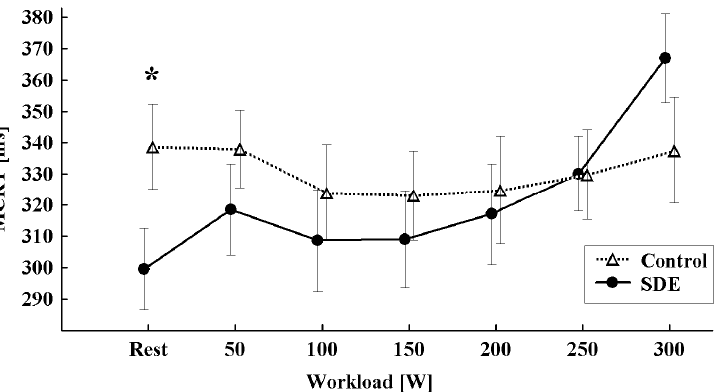
Figure 2. The multiple-choice reaction time (MCRT) during the graded exercise test to exhaustion in Control and after 30 h of sleep deprivation and exercise (SDE). Asterisk denotes a significant difference between Control and SDE trials; * p < 0.05.